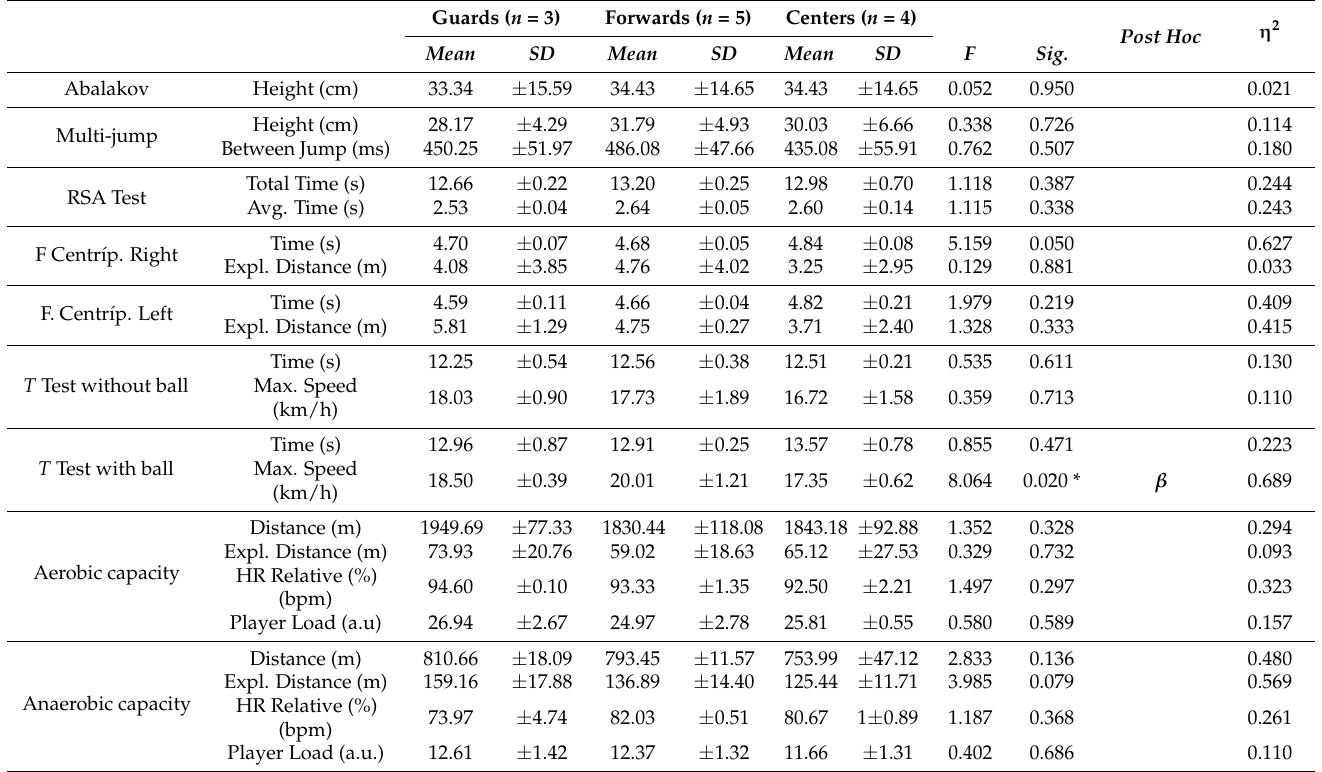
Table 3. Descriptive results of physical fitness tests grouped by game position and analysis of the differences between female